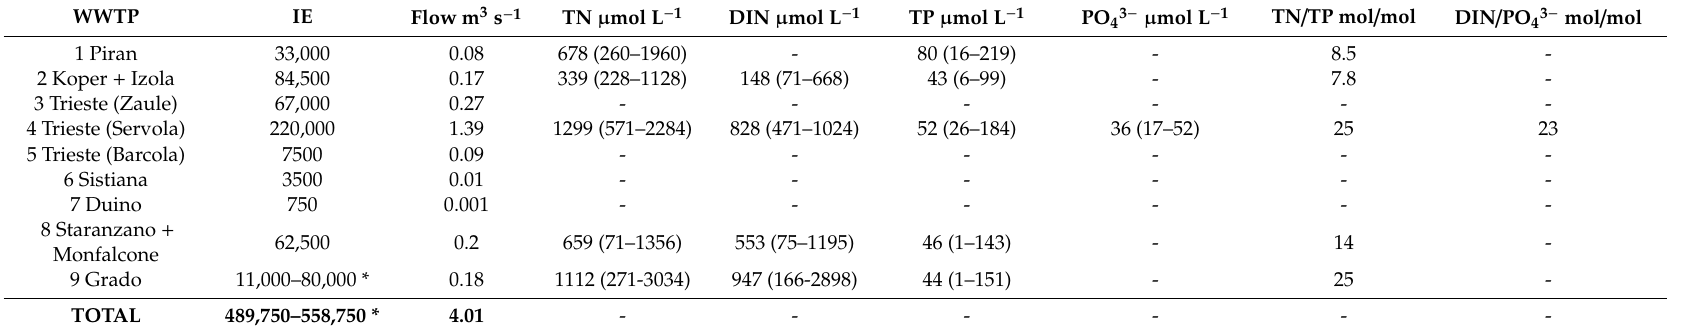
Table A3. Collecting system capacity (IE: Inhabitant Equivalent) of the WWTPs in the GoT shown in Figure 1. Mean and range of the values of the concentrations ( µ mol L − 1 ) of nitrogen and phosphorus at their outflows measured in periods included from 1996 to 2018.